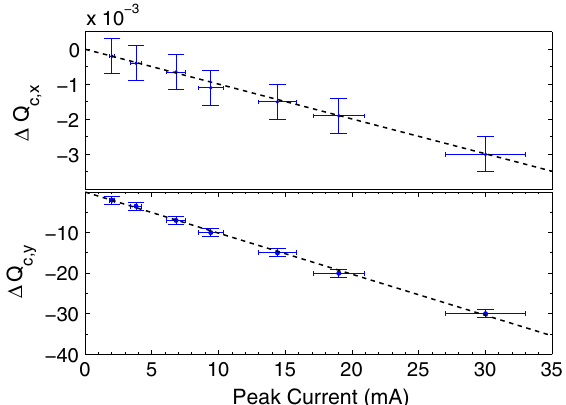
FIG. 11. Coherent tune shift obtained from the measurement for the horizontal and for the vertical planes as a function of the peak beam current. The dotted lines correspond to a linear least square error fit. The error bars in the horizontal plane are due to uncertainties in the current measurements. In the vertical plane errors result from the width of k ¼ 0 mode. The fast-Fourier- transform (FFT) resolution is (cid:4) 5 (cid:7) 10 (cid:1) 4 and is always kept higher than the mode width.